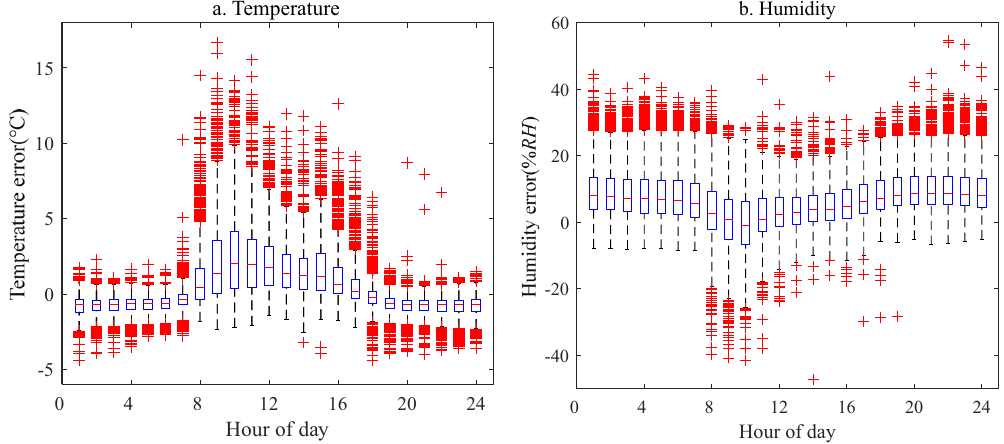
Figure 2. Diurnal variations in the errors of temperature ( a ) and humidity ( b ) observed by the wireless sensors. The x-axis indicates the time of day, and the y-axis indicates the observation errors of the wireless sensors. The upper and lower boundaries of the box indicate the 75th and 25th percentiles, respectively, (referred as Q3 and Q1, respectively) of the error bound, and the red line within the box marks the median. The error bars above and below the box indicate the maximum (Q3 + 1.5 * IQR, where IQR = Q3 − Q1) and minimum (Q1 − 1.5 * IQR), respectively. The red crosses indicate outlying